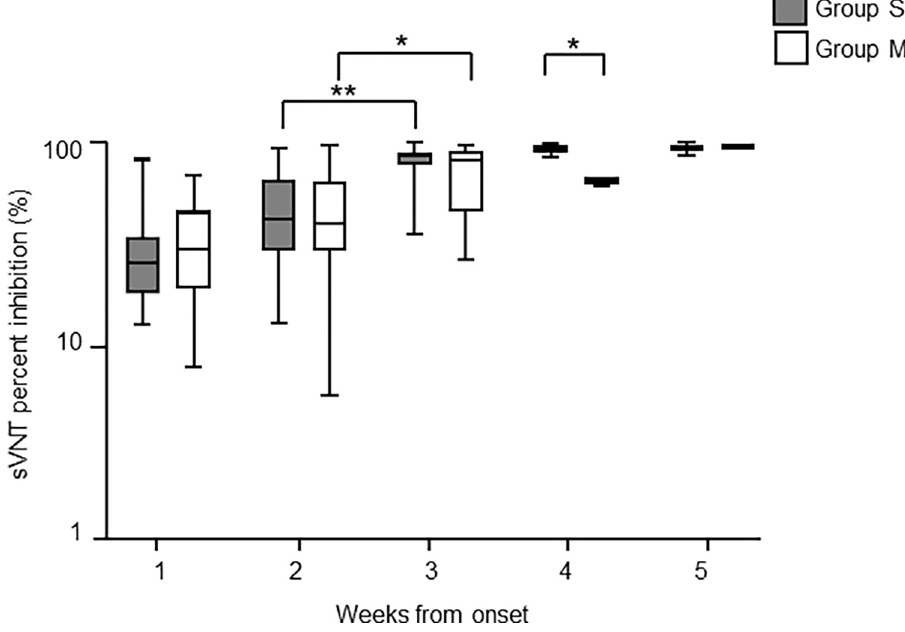
Fig 3. The time course of cPass sVNT titers in COVID-19 patients after symptom onset.